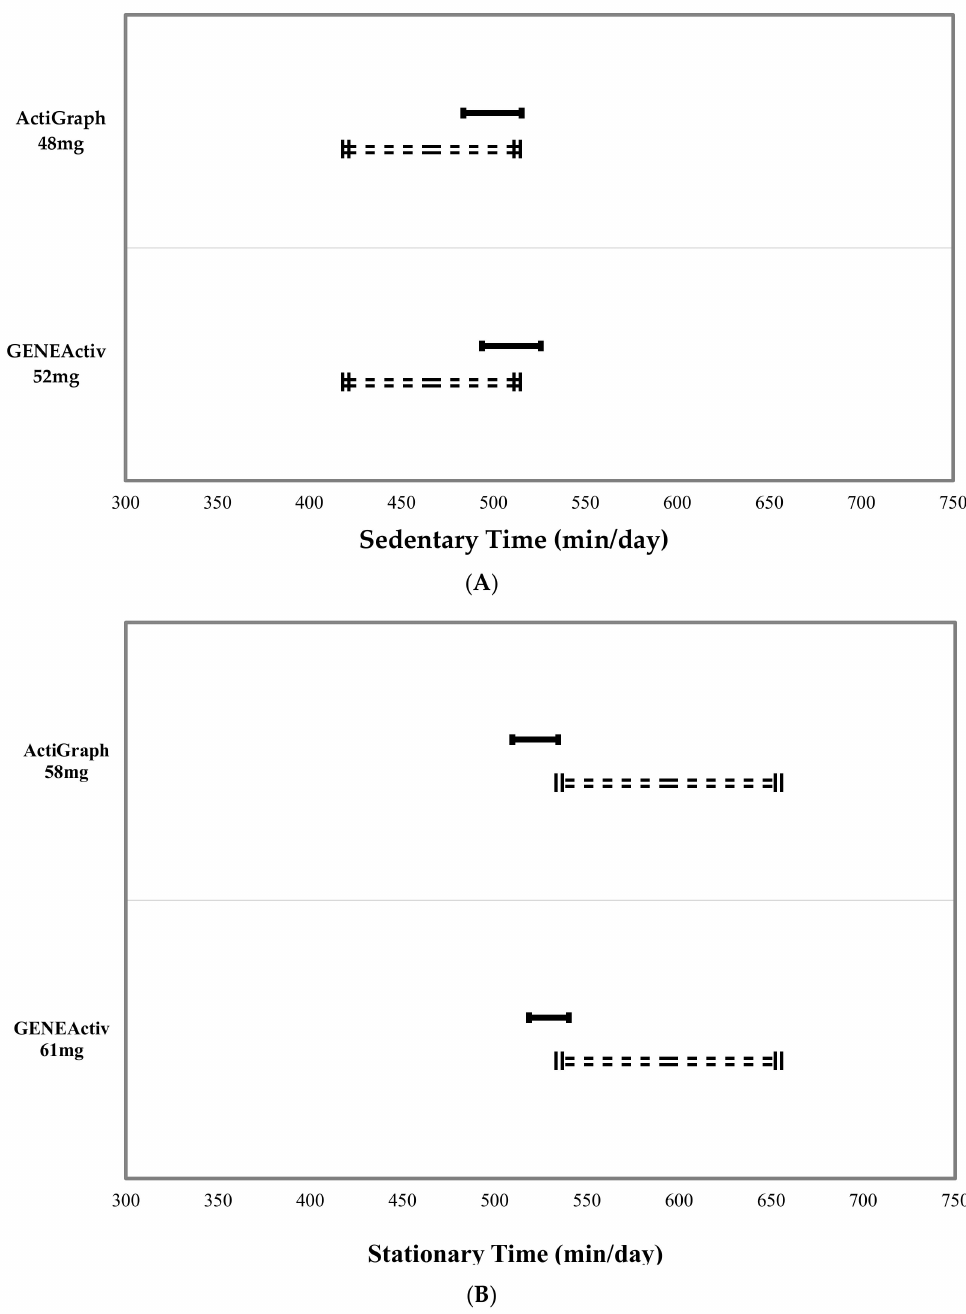
Figure 3. activPAL sedentary ( A ) and stationary ( B ) time zones of equivalence (dotted lines) and 90% confidence intervals for the ActiGraph and GENEActiv sedentary ( A ) and stationary ( B ) time estimates classified using the developed cut